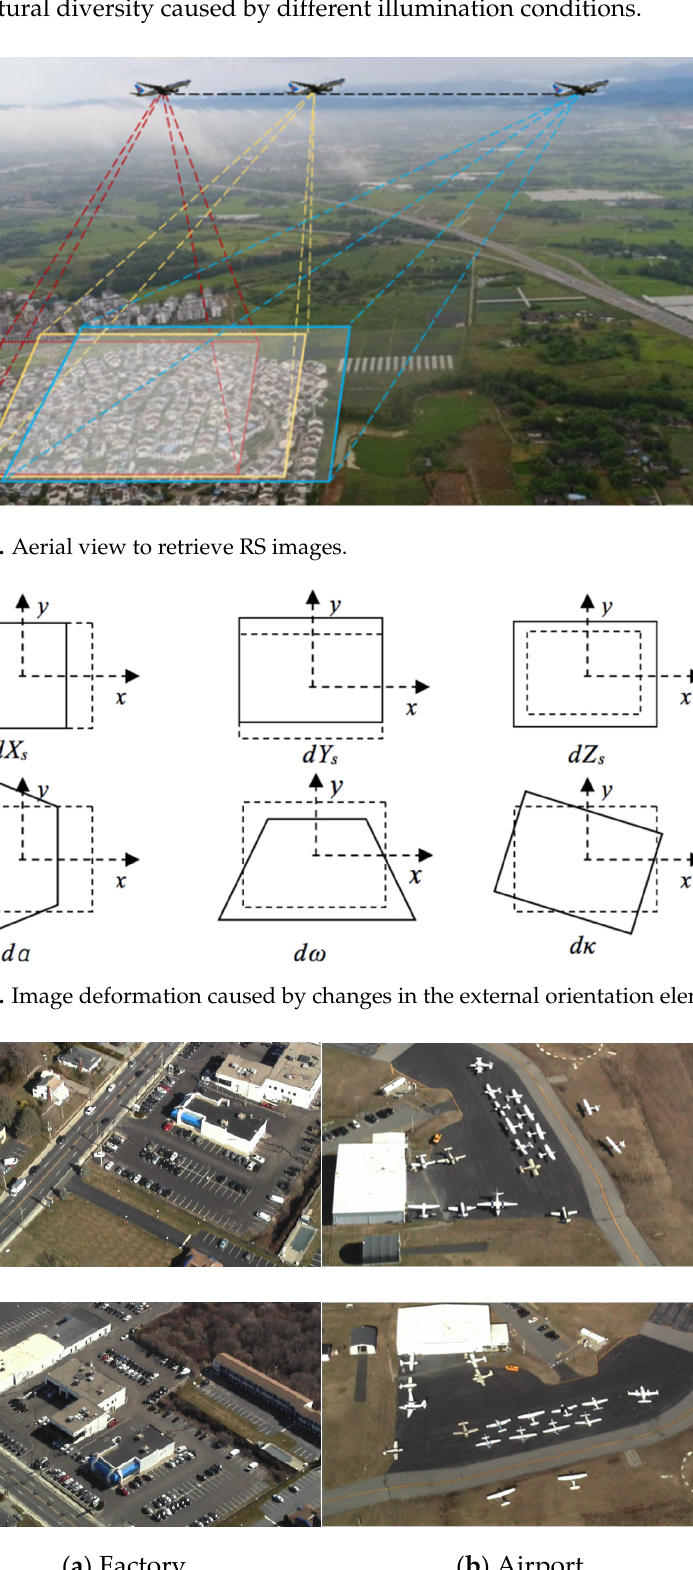
Figure 3. Examples for multiview RS images.